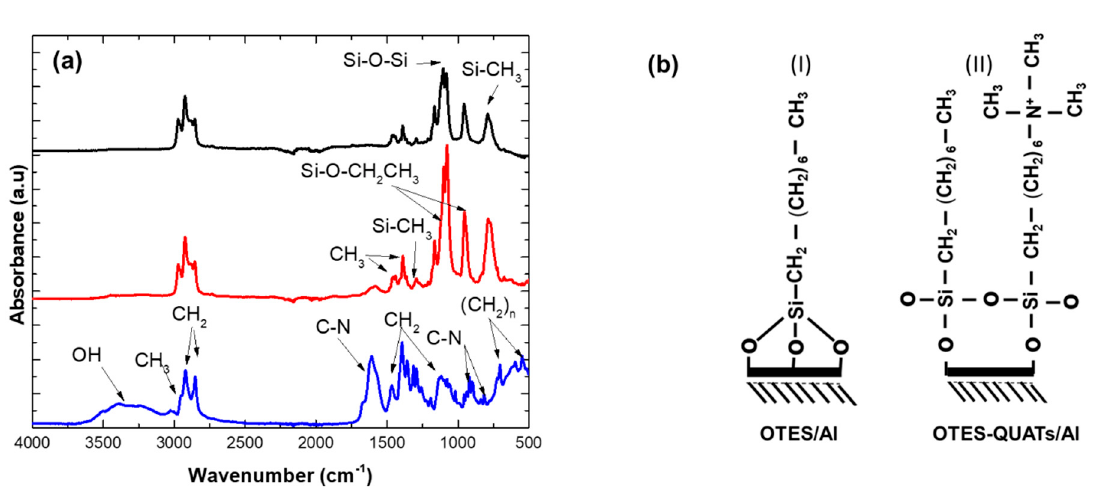
Figure 1. ( a ) Attenuated total reflection-fourier transform infrared (ATR-FTIR) spectra of: (I) Octyltriethoxysilane molecules passivated etched Al substrate (OTES / Al); (II) octyltriethoxysilane and quaternary ammonium molecules passivated etched Al substrate (OTES-QUATs / Al); (III) quaternary ammonium molecules passivated etched aluminum (QUATs / Al). ( b ) Schematic model of: (I) OTES on etched aluminum (OTES/Al); (II) formation of OTES-QUATs on etched Al, along with (OTES/Al).